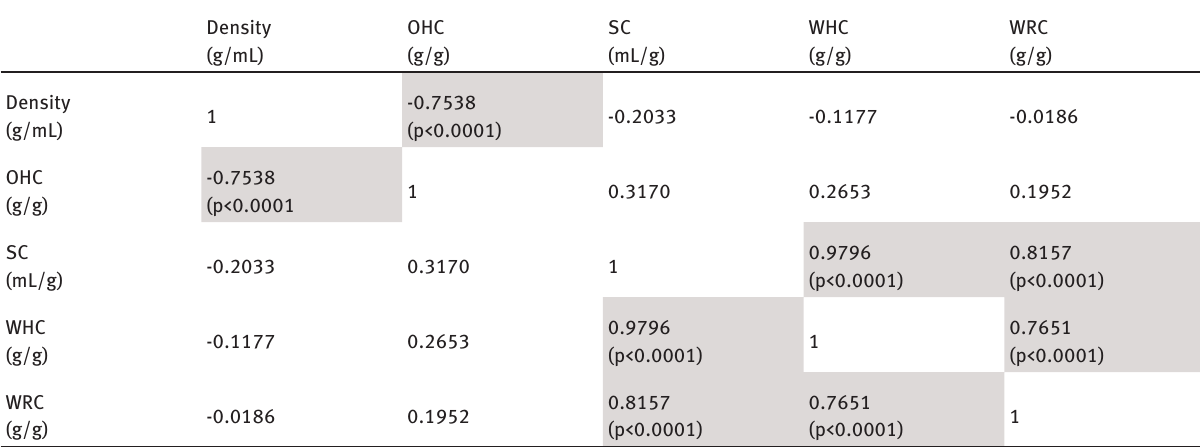
Table 6: Pearson product moment coefficients between variables for peach DF obtained with microwave